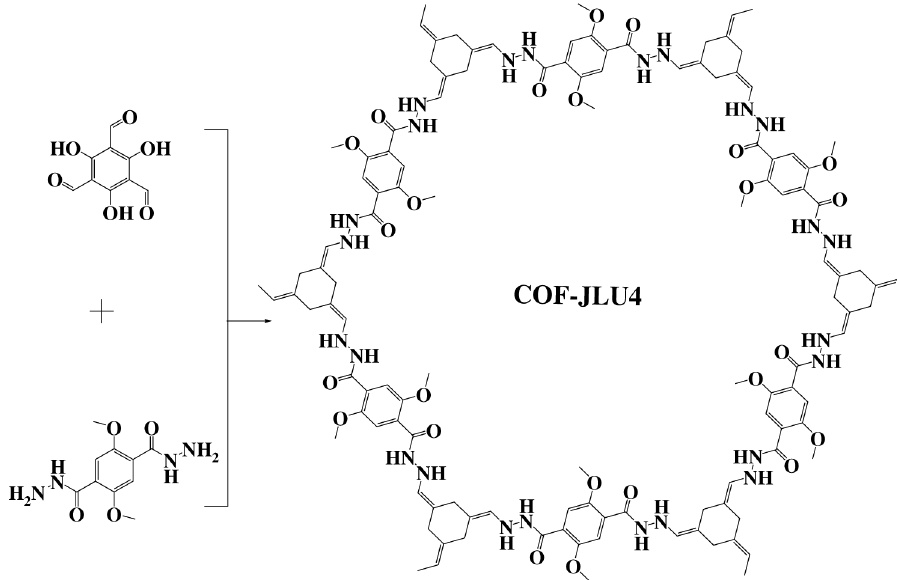
Figure 20: Synthesis and structure of